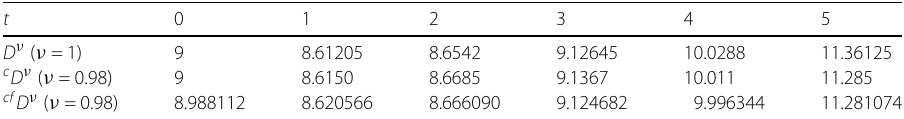
Table 1 Results of three types of derivative: Ordinary derivative D ν , Caputo fractional derivative c D ν , and Caputo–Fabrizio fractional derivative cf D ν for S ( t )